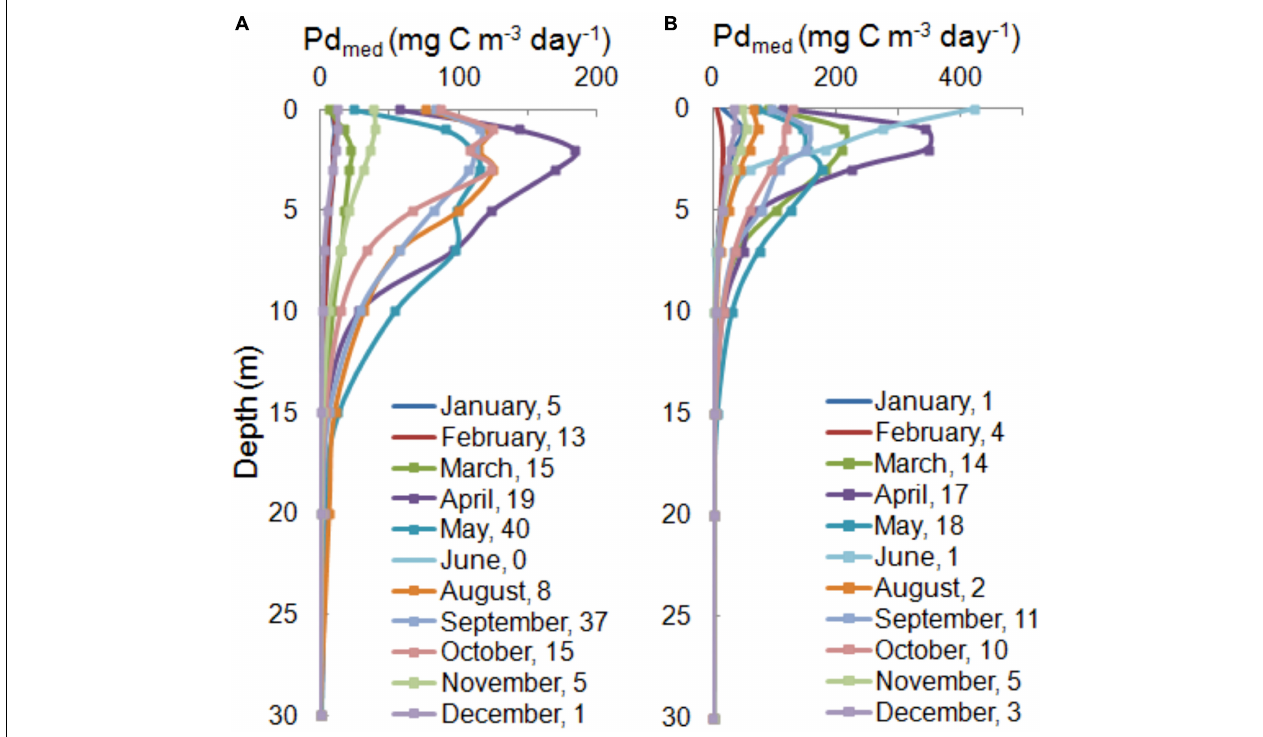
FIGURE 5 | The median of PPs in water column, Pd(z) med , 26 for the Baltic Proper (A) and the Gulf of Gdansk (B) calculated based on individual amount of data in each month from period 1993–2018 shown as number in legends.